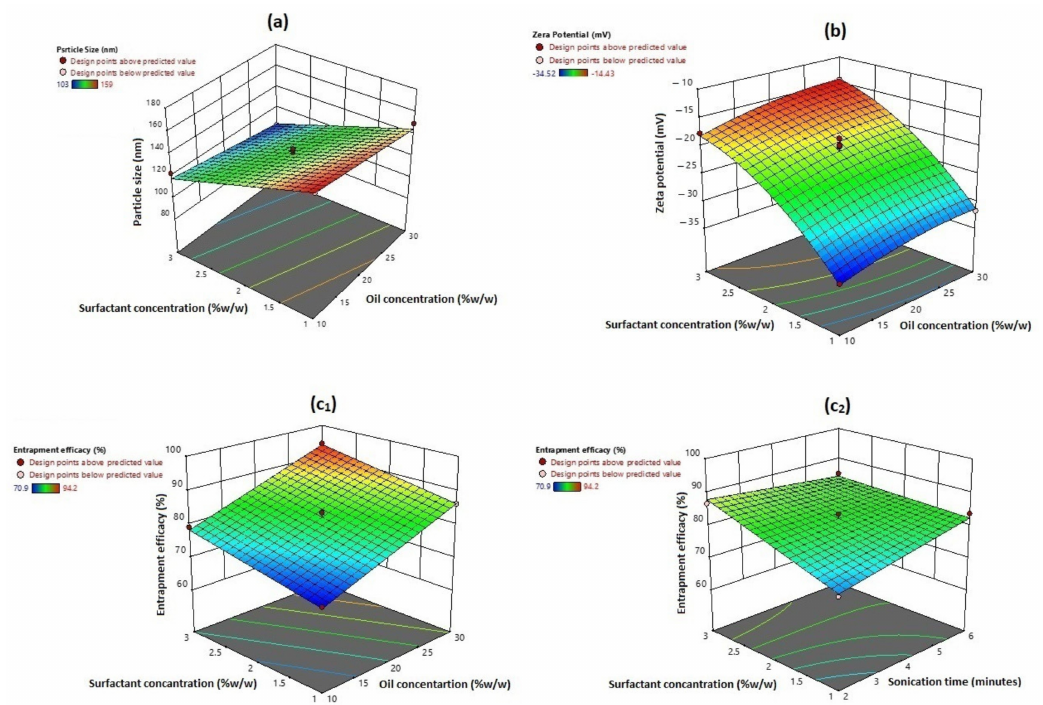
Figure 1. 3D surface plot for the effect of oil concentration (%), surfactant concentration (%), and sonication time on ( a ) particle size, ( b ) zeta potential, and ( c 1 , c 2 ) entrapment efficacy (%). Oil concentration and surfactant concentration had a significant effect on particle size, zeta potential, and entrapment efficacy, while sonication time also showed an interactive positive effect on entrapment